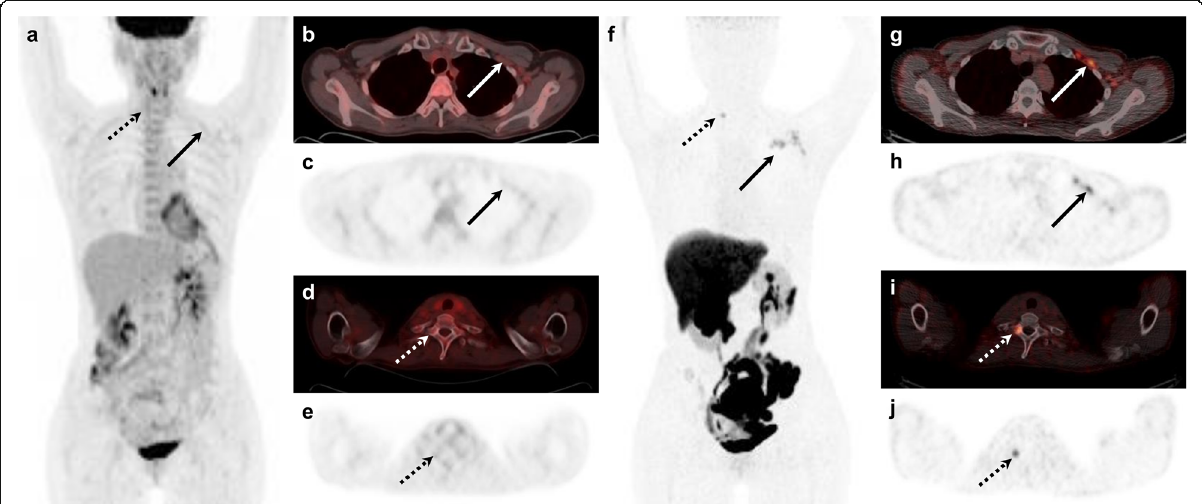
Fig. 2 [ 18 F]FDG and [ 18 F]FES PET/CT images of a 46-year-old female with lobular carcinoma and histologically confirmed ER-positive recurrence in the left axillary level II lymph node (Allred score = 8). Maximum intensity projection ( a ) and transaxial [ 18 F]FDG images ( b – e ) show equivocal uptake in the left axillary lymph node (arrows) and physiologic bone uptake in the thoracic spine (dotted arrows). However, positive [ 18 F]FES uptake is seen in the axillary lymph nodes ( f – h ; arrows) and the first thoracic vertebra ( f , i , j ; dotted